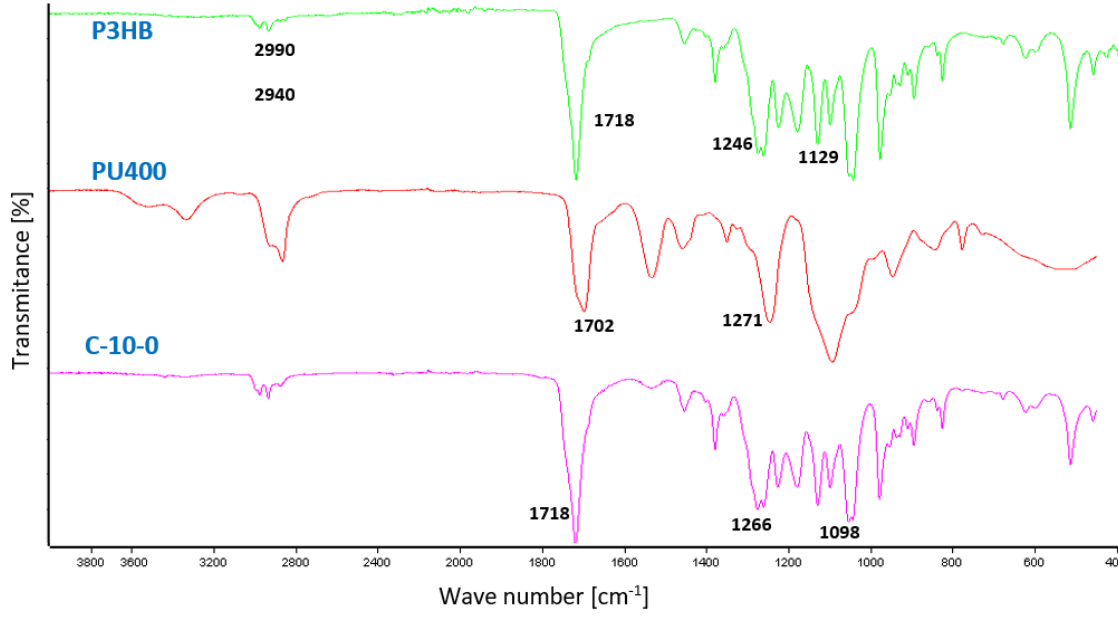
Figure 8. FTIR spectra of P3HB, polyurethane (PU400), and blend of P3HB and 10 wt.% of polyurethane (PU400) (C-10-0).